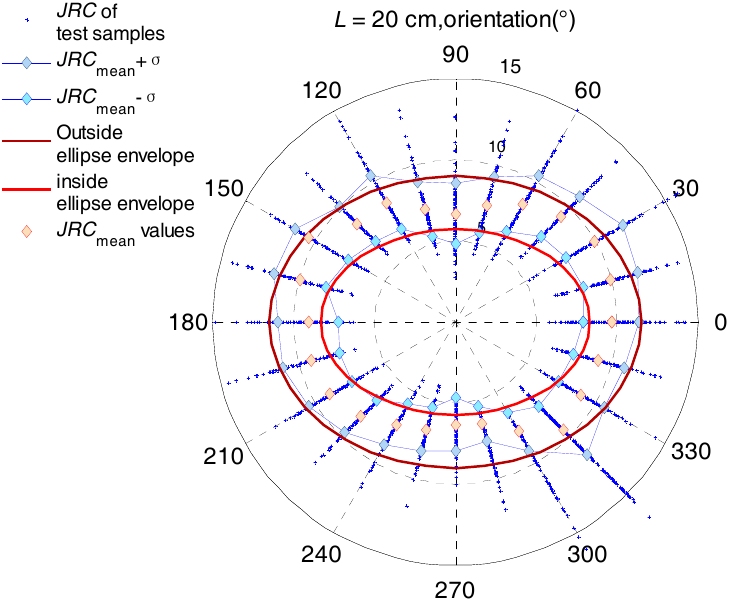
Figure 1. Polar plots of directional JRC values, upper and lower limits of JRC values and the corresponding ellipse fitting envelopes of 20 cm joint samples.